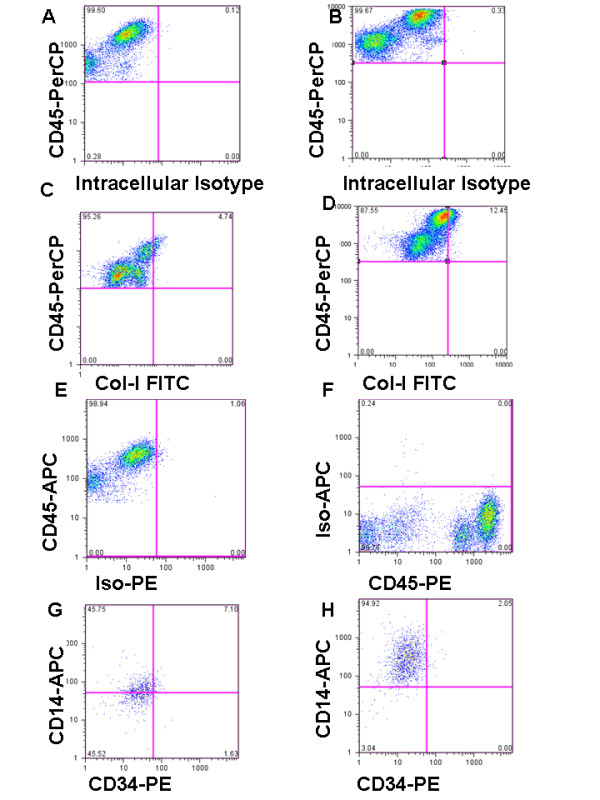
Flow cytometric detection of collagen containing monocytes in the transforming growth factor (TGF)-β1-exposed murine lung. (a,b) Fluorescein isothiocyanate (FITC)-detected intracellular isotype control (x axis) versus CD45-peridinin chlorophyll protein complex (PerCP) (y axis) in (a) Tg- and (b) Tg+ mice. This control was used to set the negative gate for FITC in each animal respectively. A shift in autofluorescence is seen in the Tg+ animals. (c,d) FITC-detected collagen (Col)-Iα1 (x axis) versus CD45-PerCP (y axis) in (c) Tg- and (d) Tg+ mice. An increase in double positive cells is seen in the Tg+ animals. (e) Phycoerythrin (PE) -isotype control (x axis) versus CD45-anti-allophycocyanin (APC) (y axis). This control was used to set the negative gate for PE. (f) CD45-PE (x axis) versus APC-isotype control (y axis). This control was used to set the negative gate for APC. (g,h) CD34 (x axis) and CD14 (y axis) on the CD45+Col-Iα1+ population identified in (g) Tg- and (h) Tg+ mice. In contrast to Tg- mice, in which the CD45+Col-Iα1+ cells express CD14 and CD34 to varying degrees, the CD45+Col-Iα1+ cells that appear in response to TGF-β1 overexpression are almost uniformly CD14+, with minimal contribution of CD34+ cells. N = 5 mice/group, images are representative of all animals.